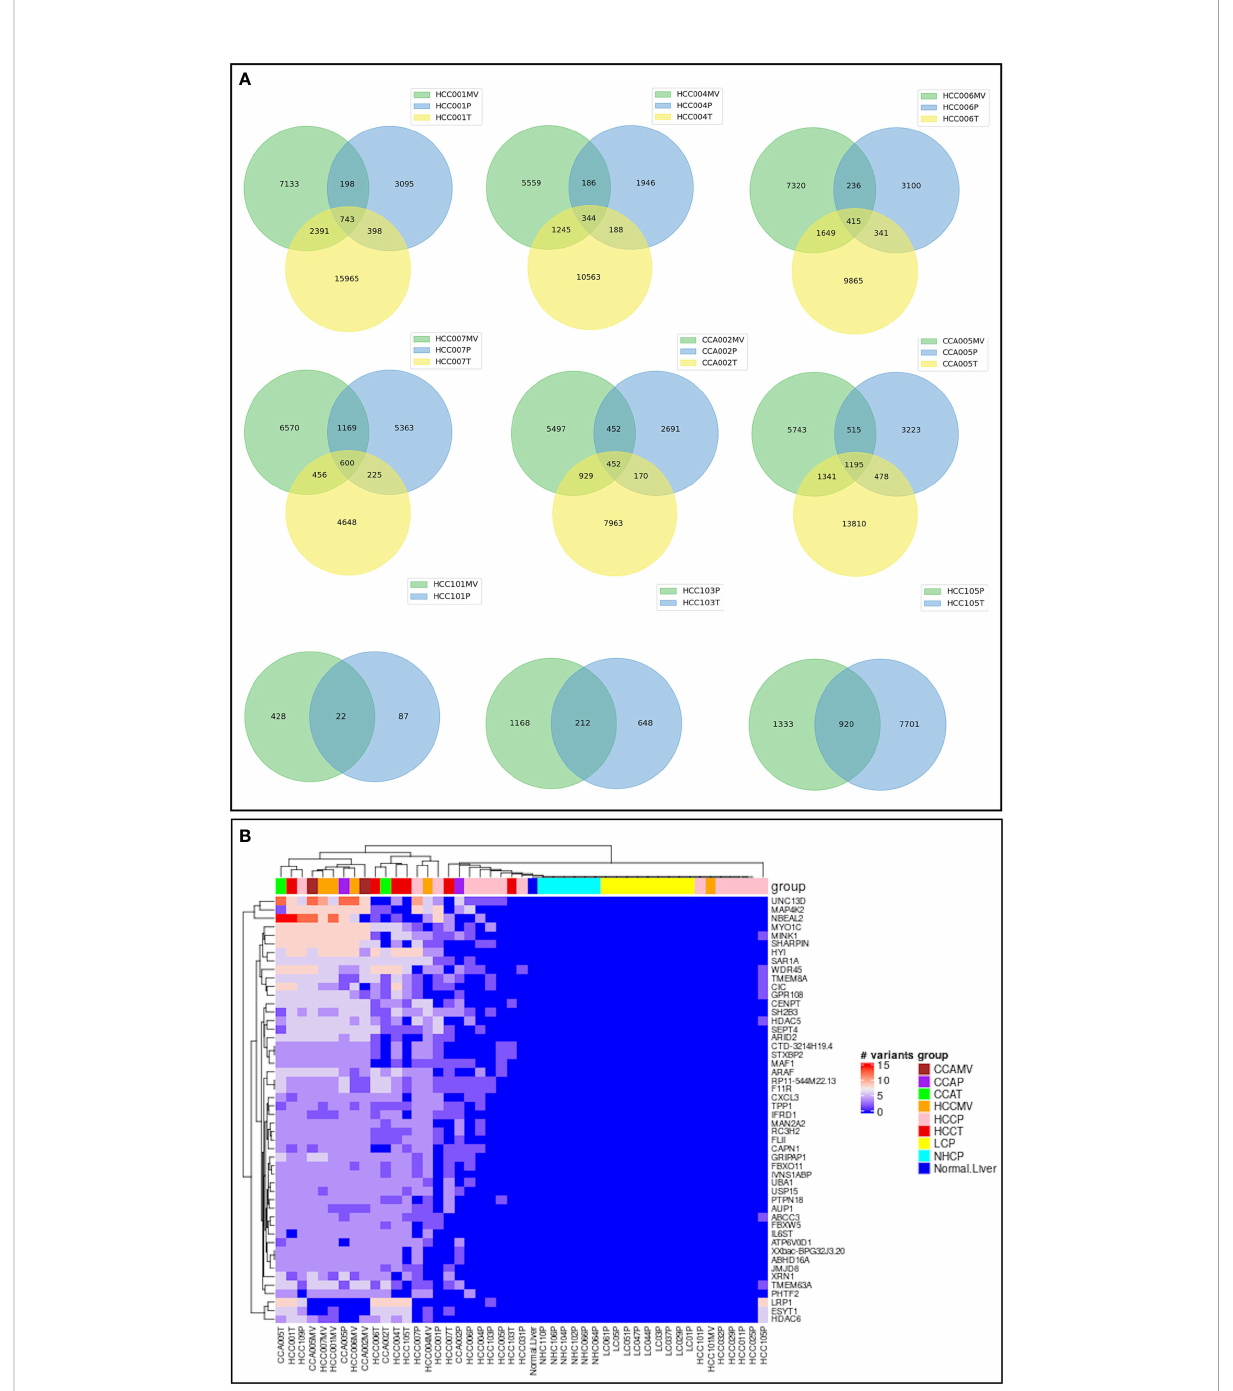
FIGURE 6 Concordance of high-risk variants in three matching samples from same cancer patients. (A) . Venn diagrams corresponding to 6 cancer patients (4 HCC, 2 CCA) with three matching specimens, EVs, tumor and plasma from each subject and three subjects with two matching specimens. The numbers represent the distribution and concordance of high-risk mRNA variants in multiple samples from same patients. (B) . Heat map representation of top genes carrying highest number of high-risk concordant variants. The number of high-risk variants, which were identi fi ed simultaneously in different types of samples (plasma, tumor, and/or vesicle) from same cancer patient, but not presented in any of liver cirrhosis or healthy control, were summarized by gene carrying them. The fi rst 50 genes carrying the most of such high-risk concordant variants were selected and the numbers of variants on those genes were plotted against samples. UNC13D shown at the top, for example has the highest number of variants in HCC patient specimens. Annotation and pro fi les of these variants can be found in the Supplementary Table